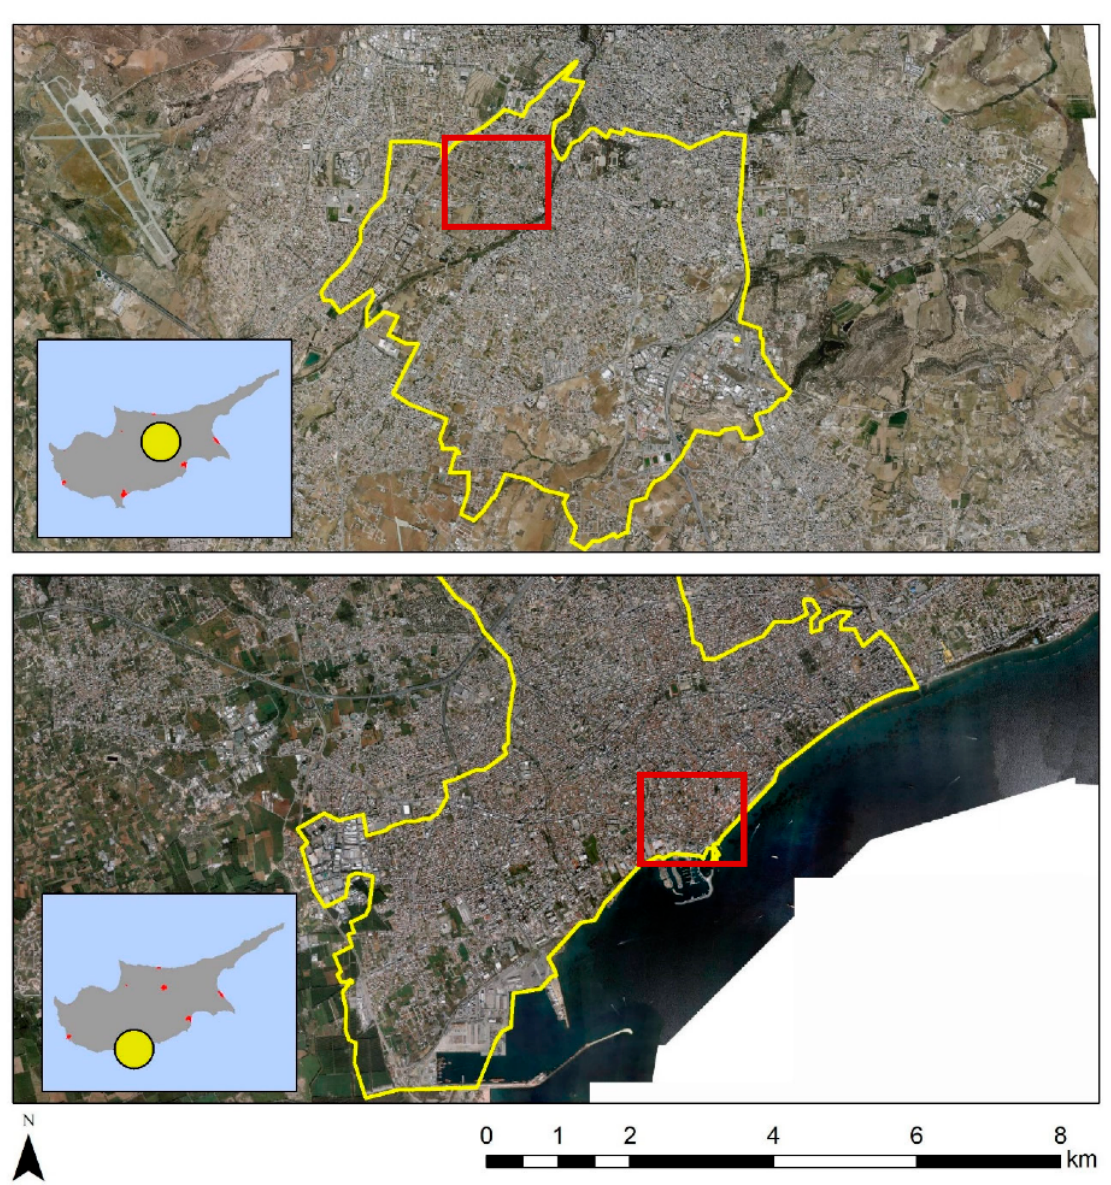
Figure 2. The municipalities of Strovolos ( top ) and Limassol ( bottom ) in Cyprus, selected as case studies. Red polygons include specific historic buildings under investigation here.